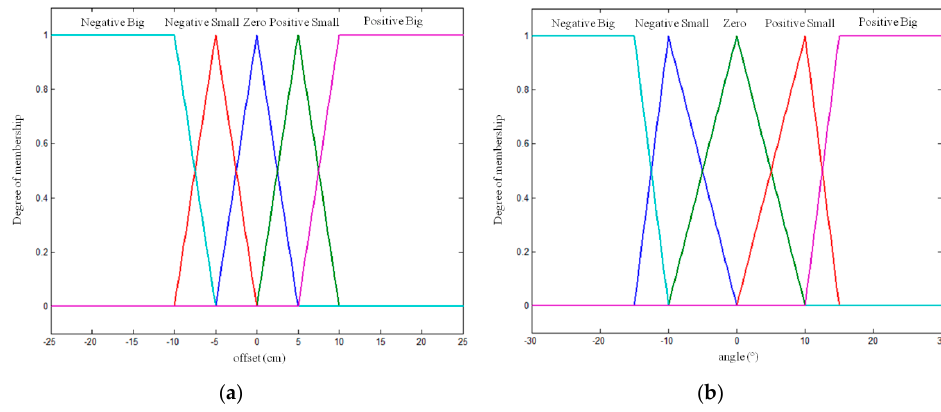
Figure 10. Angular speed controller. Fuzzy sets of input variables: ( a ) offset and ( b ) angle. Sensors 2016 , 16 , 276